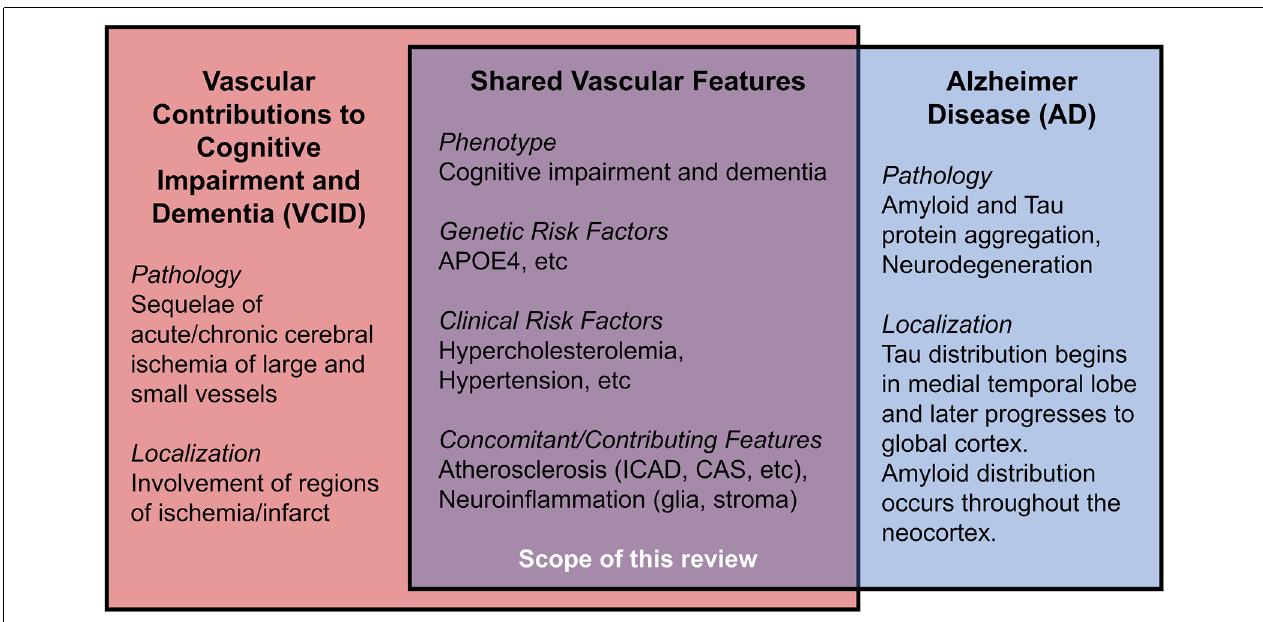
FIGURE 1 | Shared features in Vascular Contributions to Cognitive Impairment and Dementia (VCID) and Alzheimer Disease